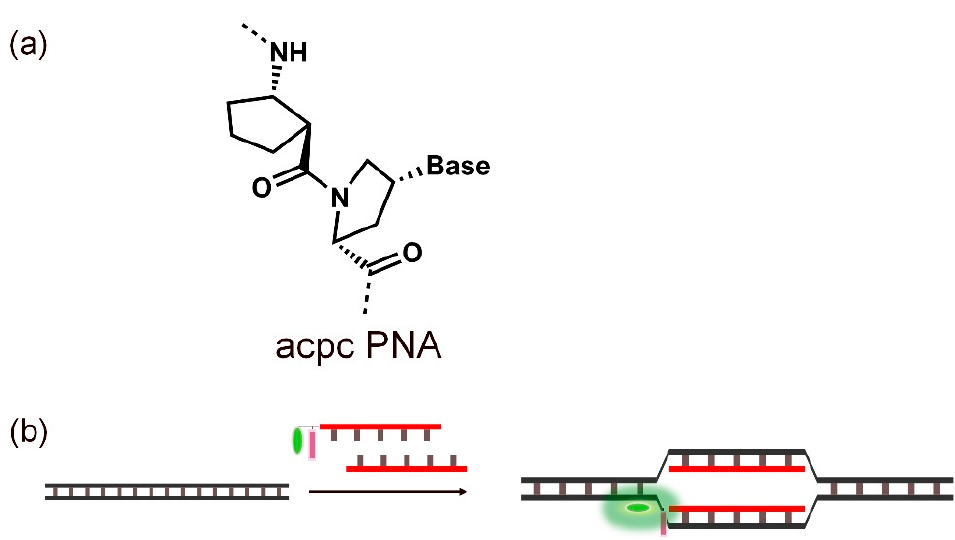
Figure 10. ( a ) Chemical structure of acpcPNA. ( b ) Invasion complex formation by fluorophore-labeled acpcPNAs due to steric hindrance between acpcPNAs.